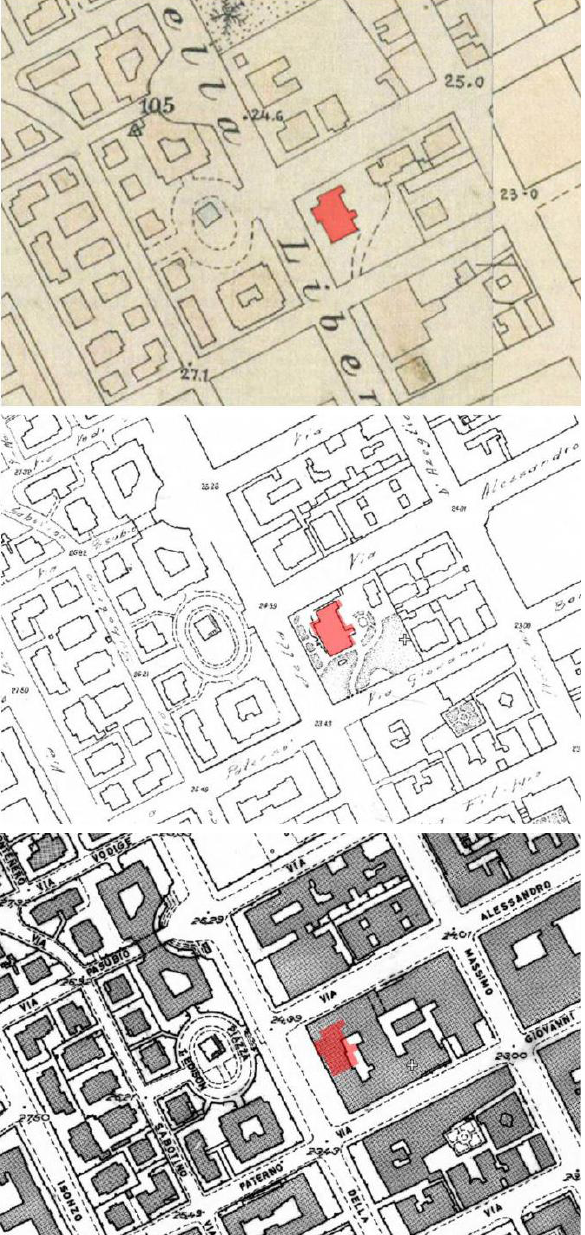
Figure 9 . Urban evolution of the area of ​ ​